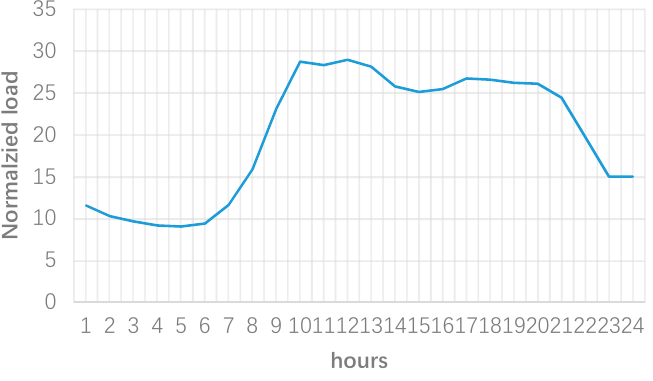
Figure 3. Load curve of all consumers.